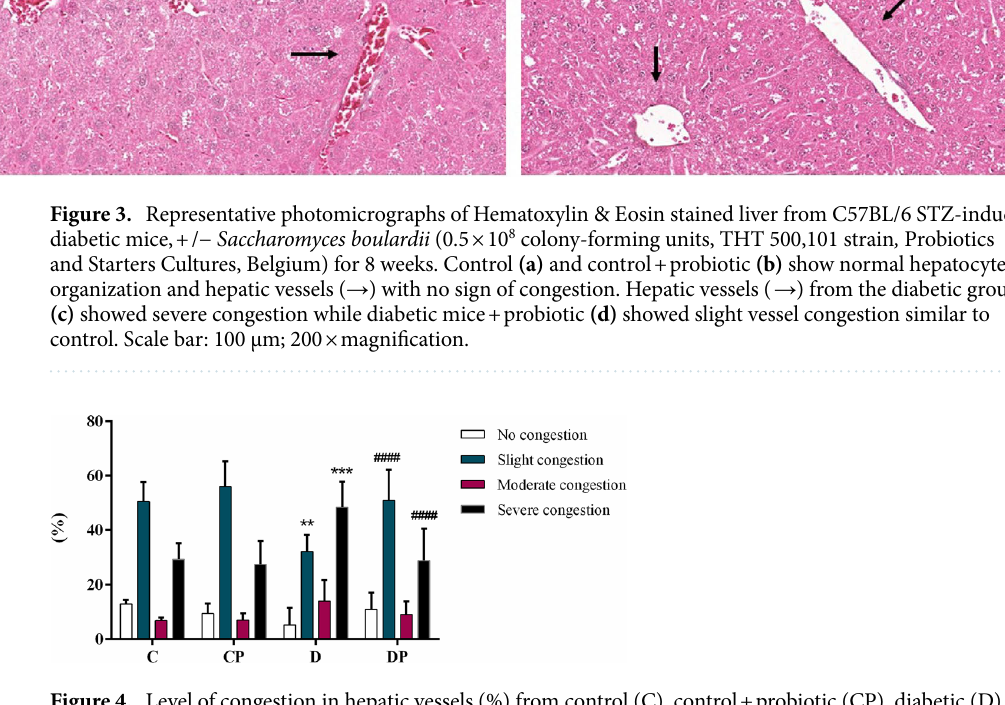
Figure 4. Level of congestion in hepatic vessels (%) from control (C), control + probiotic (CP), diabetic (D) and diabetic + probiotic (DP) groups (n = 6–9/group). Data are from C57BL/6 STZ-induced diabetic mice, + /− Saccharomyces boulardii (0.5 × 10 8 colony-forming units, THT 500101 strain , Probiotics and Starters Cultures, Belgium) for 8 weeks. Two-way ANOVA followed by Tukey test for multiple comparisons of means (GraphPad Prism 6). **p ≤ 0.01, ***p ≤ 0.001 versus C in the same degree of injury; and #### p ≤ 0.0001 versus D in the same degree of